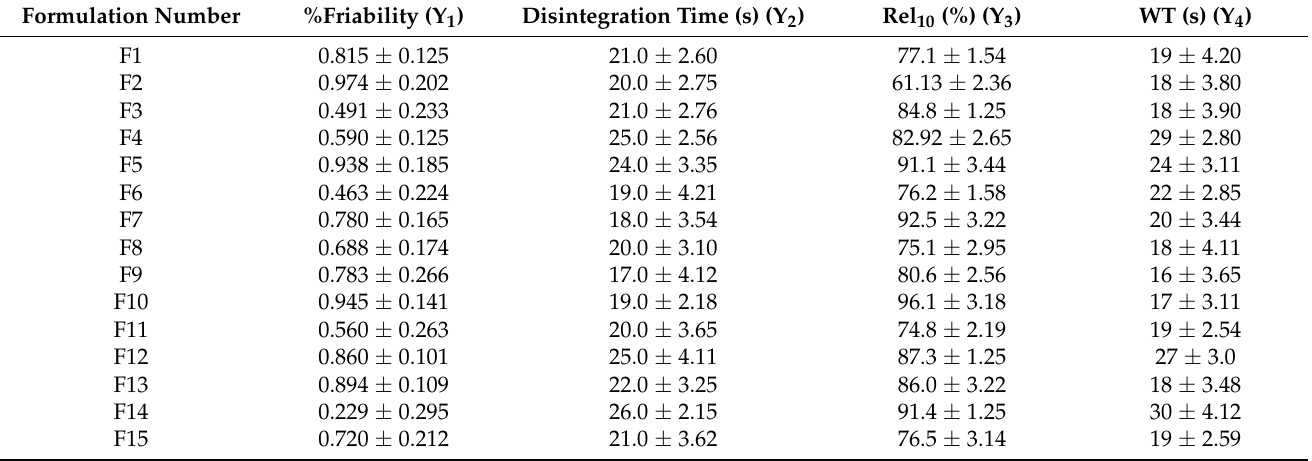
Table 5. Three factors, three levels factorial design layout showing factor combinations and response parameters of